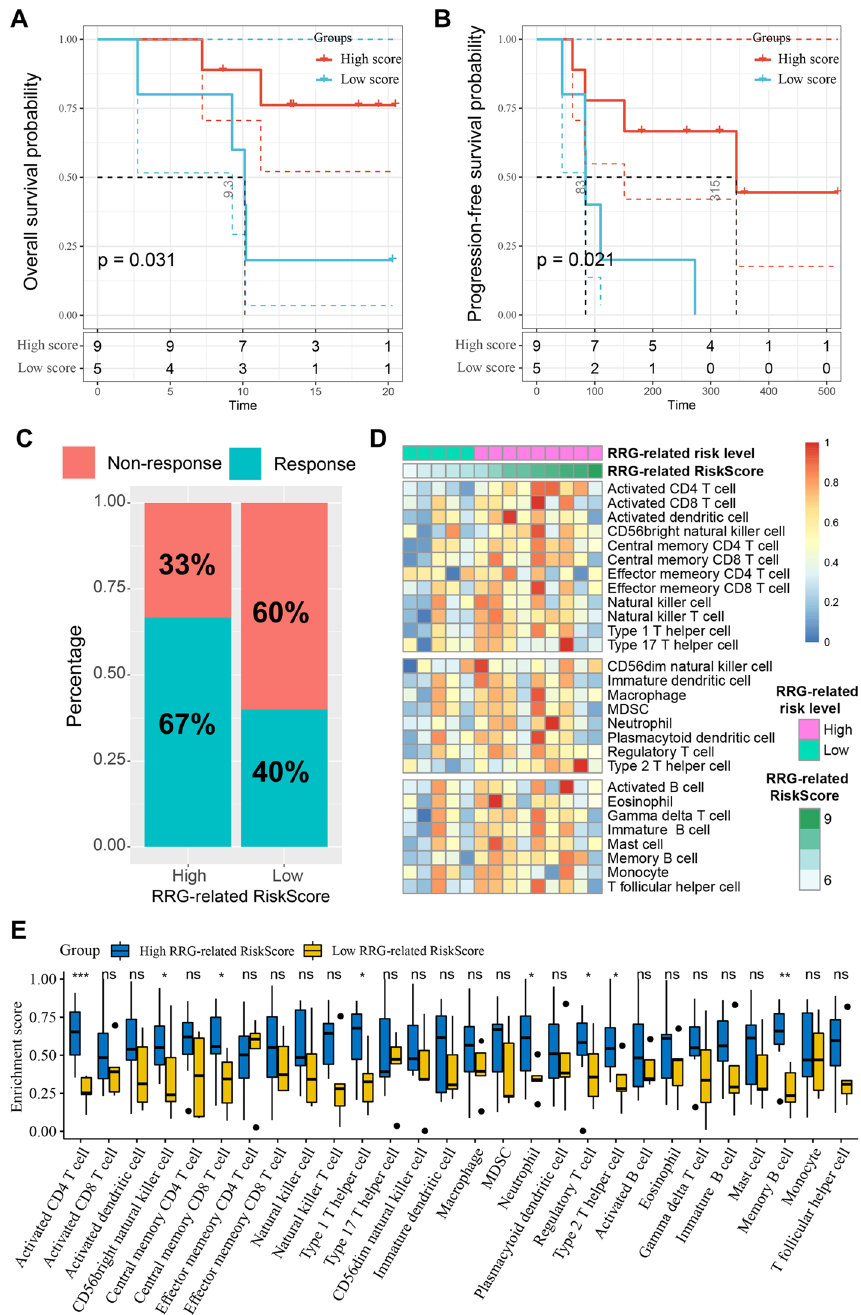
Fig. 10 The RRG-related RiskScore predicts immunotherapeutic benefits. a , b Kaplan–Meier curves for OS ( a ) and PFS ( b ) showing the difference in survival between high-RiskScore group and low-RiskScore group (log-rank test, p < 0.0001). High-RiskScore group is indicated in red line and low-RiskScore group in blue. c Rate of clinical response (Response and Non-response) to anti-PD-1 immunotherapy in high or low RiskScore groups. d Heatmap of 28 previously reported immune cells infiltration in high-RiskScore group and low-RiskScore group. e Boxplots of the relationship between RRG-related RiskScore and 28 immune cell subpopulations. The upper and lower ends of the boxes represented interquartile range of values. The lines in the boxes represented median value, and black dots showed outliers. * P < 0.05, ** P < 0.01, *** P <